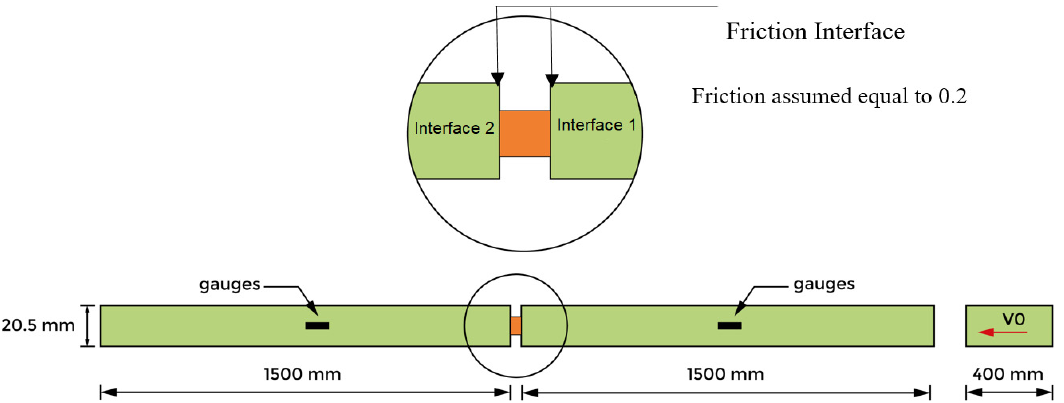
Figure 2. Schematic description of the Hopkinson bar device.